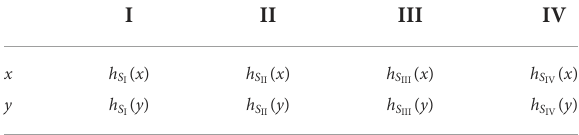
TABLE 3 The hysteresis effects of each dimension in each